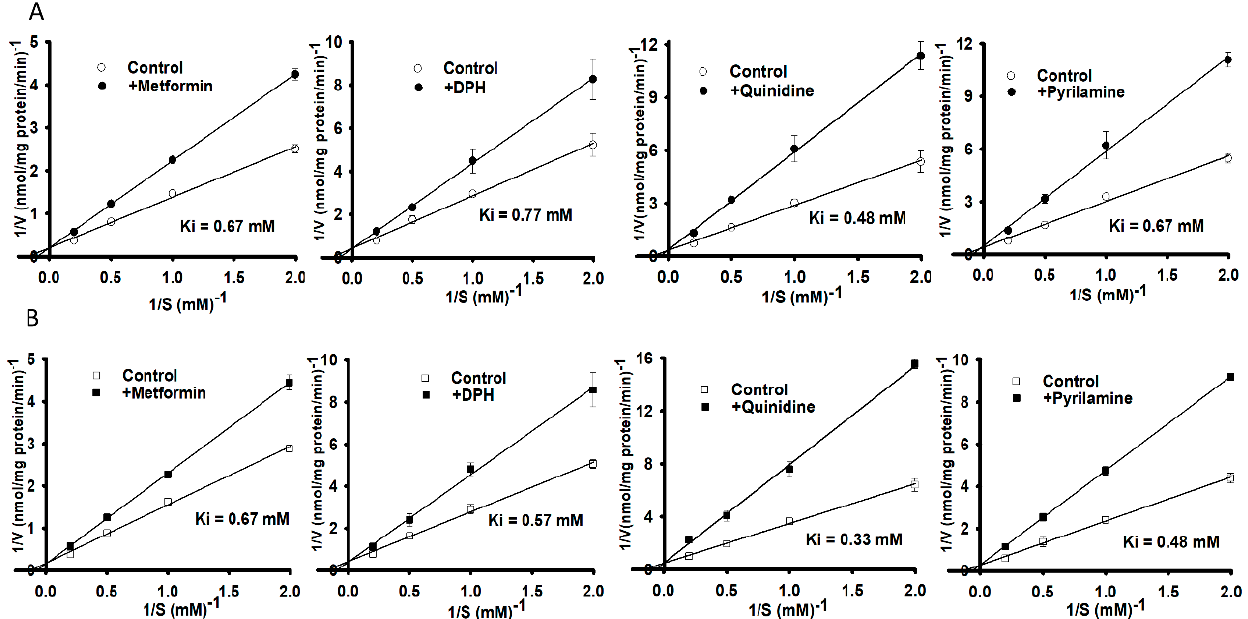
Figure 4. A kinetic inhibition study of [ 3 H]L-carnitine in NSC-34 cell lines was performed via Lineweaver-Burk plots. Uptake for 15 min was evaluated in the presence or absence of 0.5 mM metformin, diphenhydramine (DPH), quinidine and pyrilamine in ( A ) WT (circle) and ( B ) MT (square) cell lines at 37 °C under physiological pH. Each value represents the mean ± S.E.M ( n = 3) of three independent experiments.